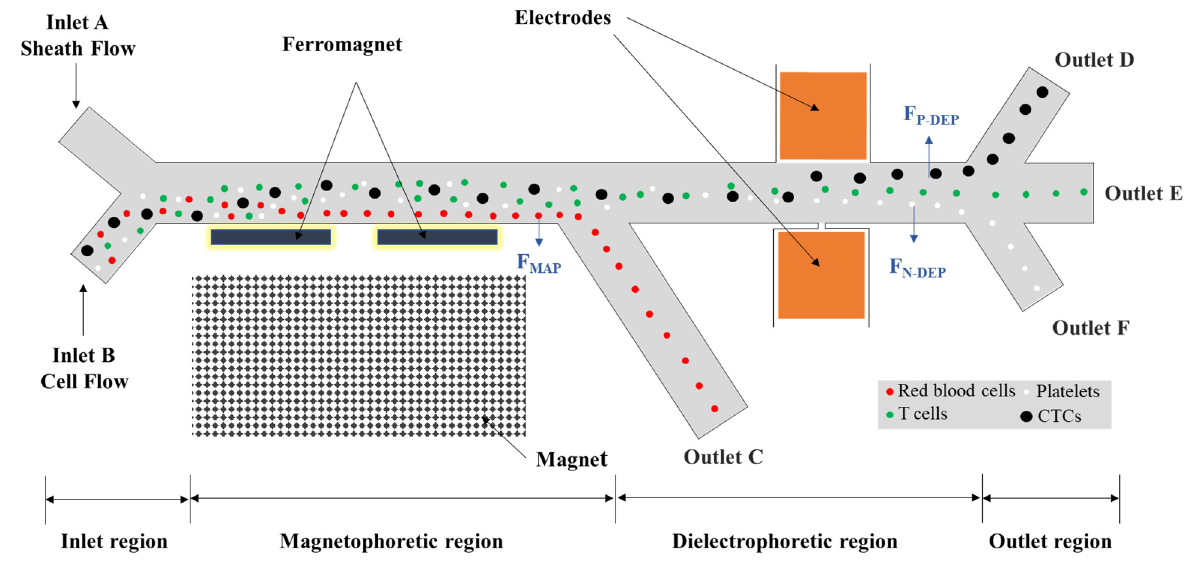
Figure 1. The schematic illustration of the microfluidic channel. Magnetophoresis refers to the movement of particles in a magnetic field [57]. If a particle is suspended in a magnetic fluid medium with a relative magnetic permeability of u m , the magnetophoretic force acting on a spherical particle with a radius of r can be expressed as